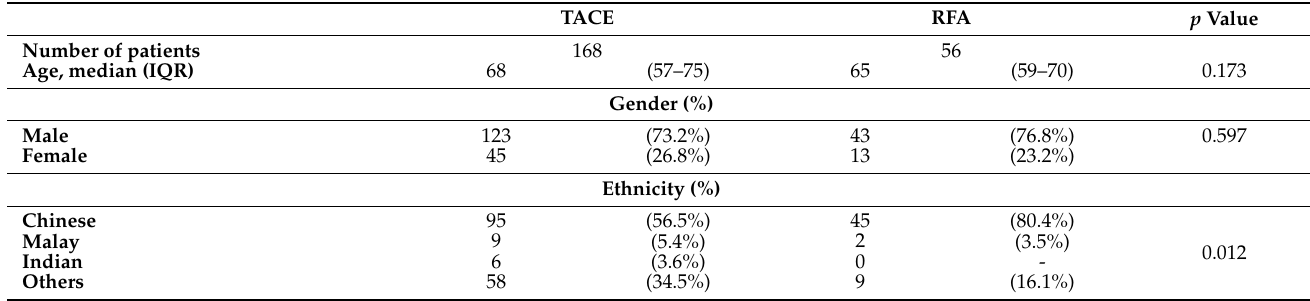
Table 1. Baseline characteristics of all 224 study